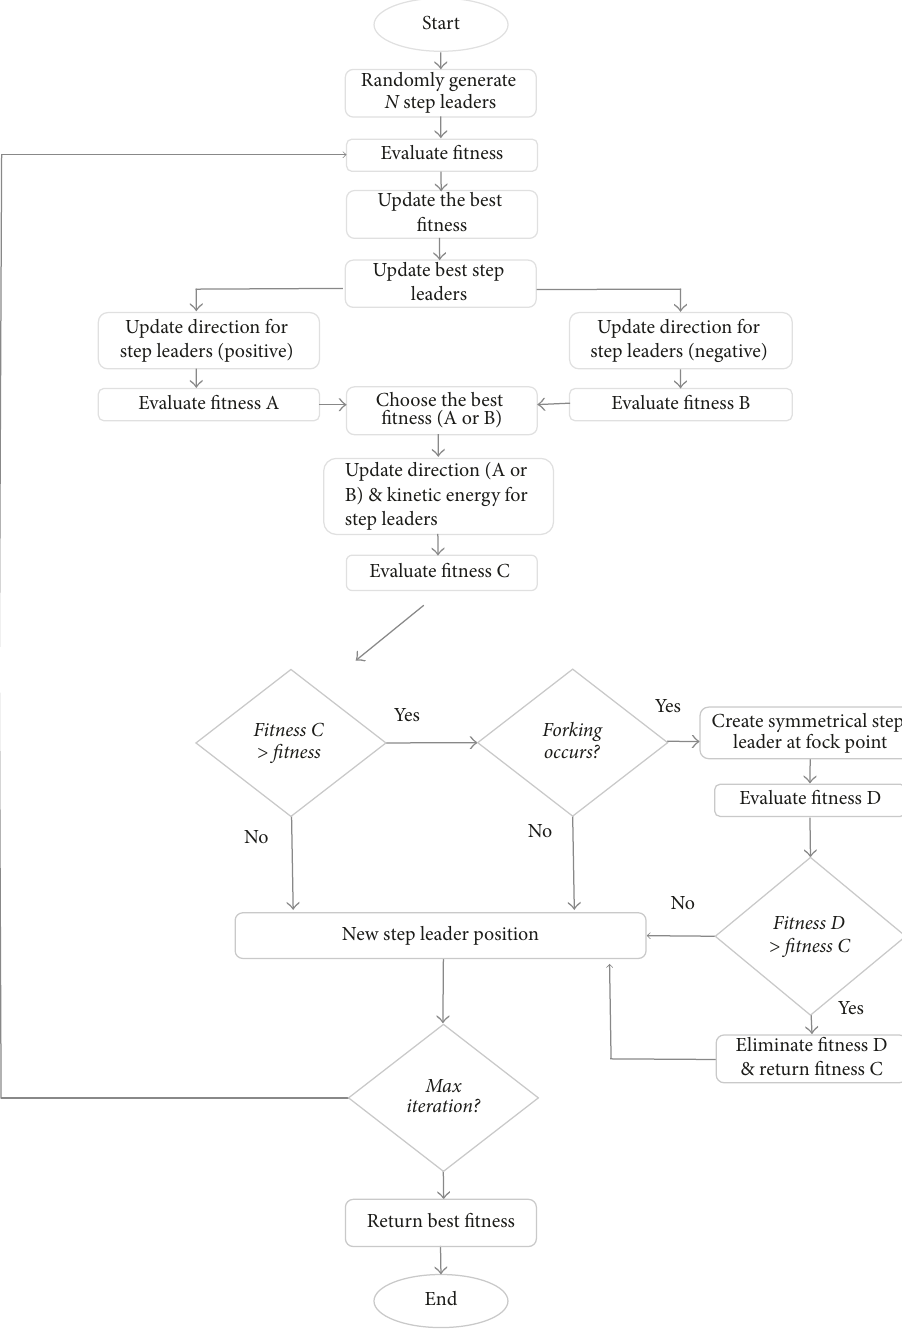
Figure 8: Flowchart for MLSA method to get minimum fitness with weightage summation approach.